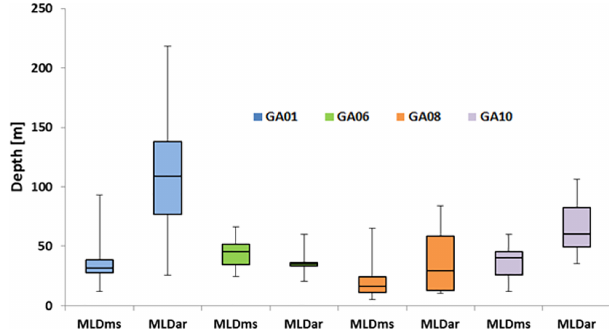
Figure 2. Box whisker plot for the MLD determined using in situ measurements (MLDms) and annual mixed-layer climatol- ogy (MLDar) (http://mixedlayer.ucsd.edu/, last access: September 2017) (Holte et al.,